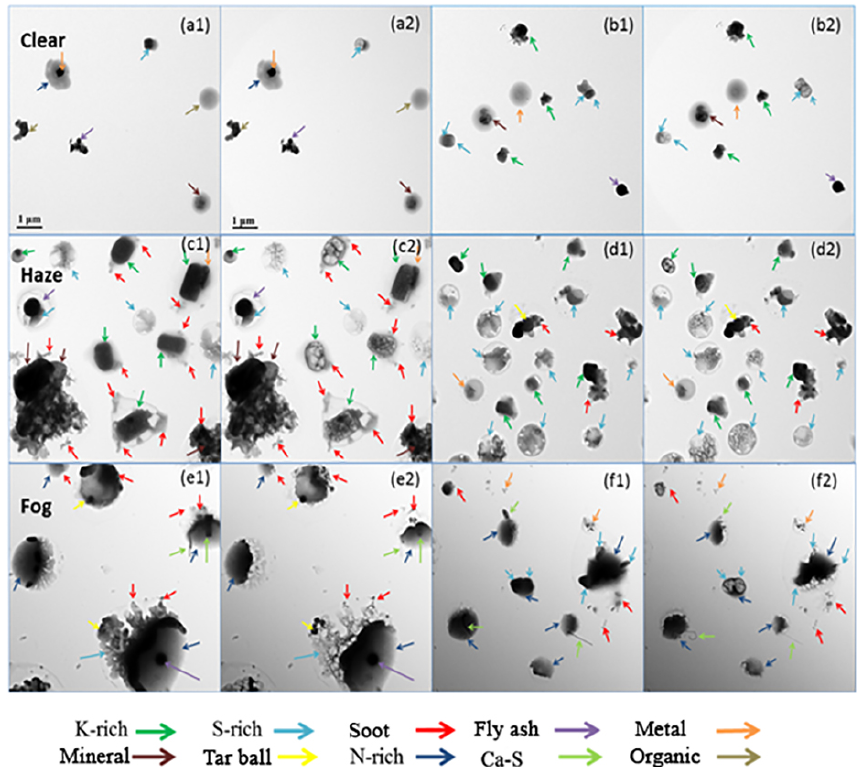
Figure 6. TEM typical views of the particles in clear (upper row), haze (middle row) and fog episodes (bottom row). Ten components are marked with the coloured arrows. Images (a1) – (f1) are obtained before the electron exposure and (a2) – (f2) are after exposure. A fraction of S-rich particles and other unstable particles decompose after electron